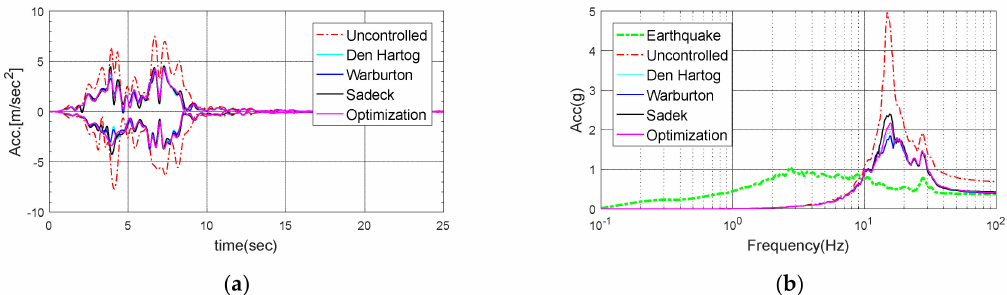
Figure 25. Response of the electrical cabinet subjected to Nicaragua-01: ( a ) Time history; ( b ) Response spectrum.